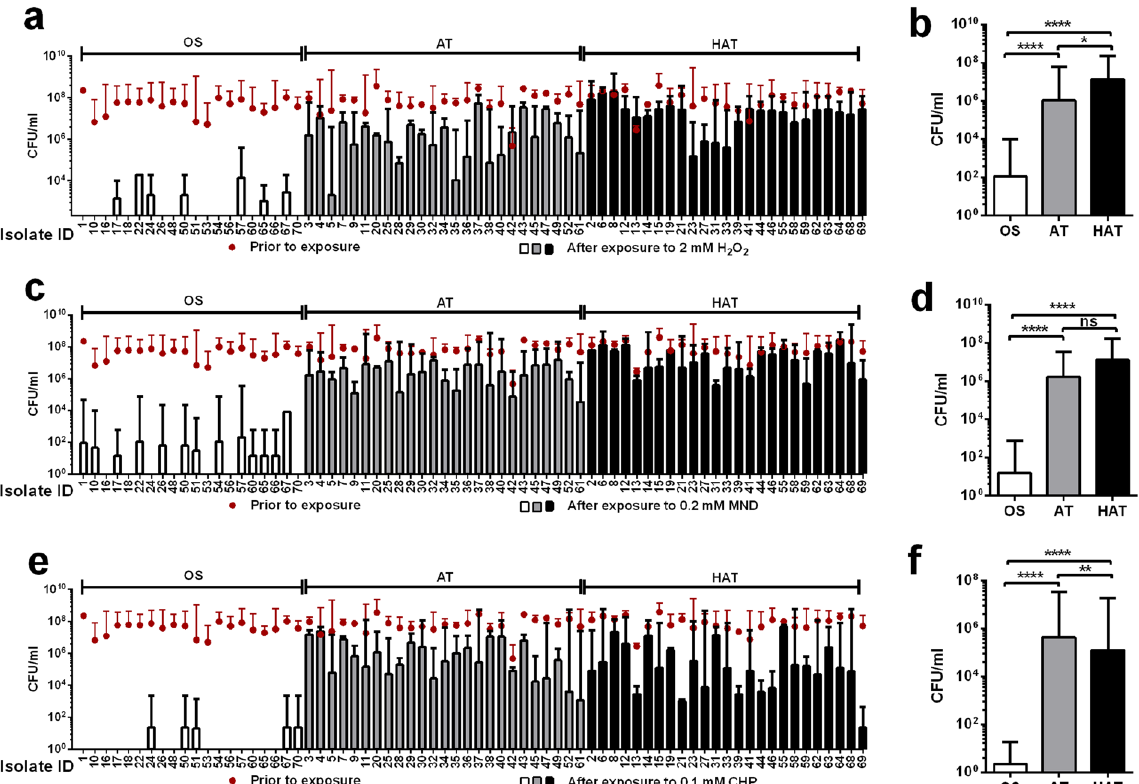
Figure 3. Tolerance to oxidants in 70 strains of C . jejuni from retail chicken. Viability after 1 h exposure to hydrogen peroxide (H 2 O 2 ) in 70 strains ( a ) and the means of CFU in OS, AT, and HAT strains ( b ), menadione (MND) in 70 strains ( c ) and the means of CFU in OS, AT, and HAT strains ( d ), and cumene hydroperoxide (CHP) in 70 strains ( e ) and the means of CFU in OS, AT, and HAT strains ( f ). The results show the means and standard deviations of the viability (CFU/ml) in a single experiment with triplicate samples. The CFU level of the inoculum is indicated with a dot graph in red. The experiment was repeated three times. Statistical significance was carried out with two-way ANOVA. ns: not significant, * P < 0.05, ** P < 0.01, **** P <